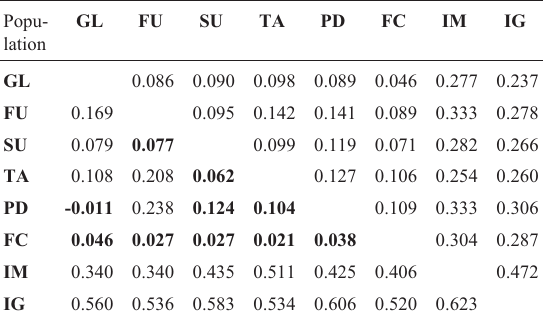
Table2 -Pairwiseestimatesof (cid:1) (abovediagonal)and (cid:2) (belowdiagonal) between N. squamipes populations. Values in bold are not significant (Bonferroni correction).